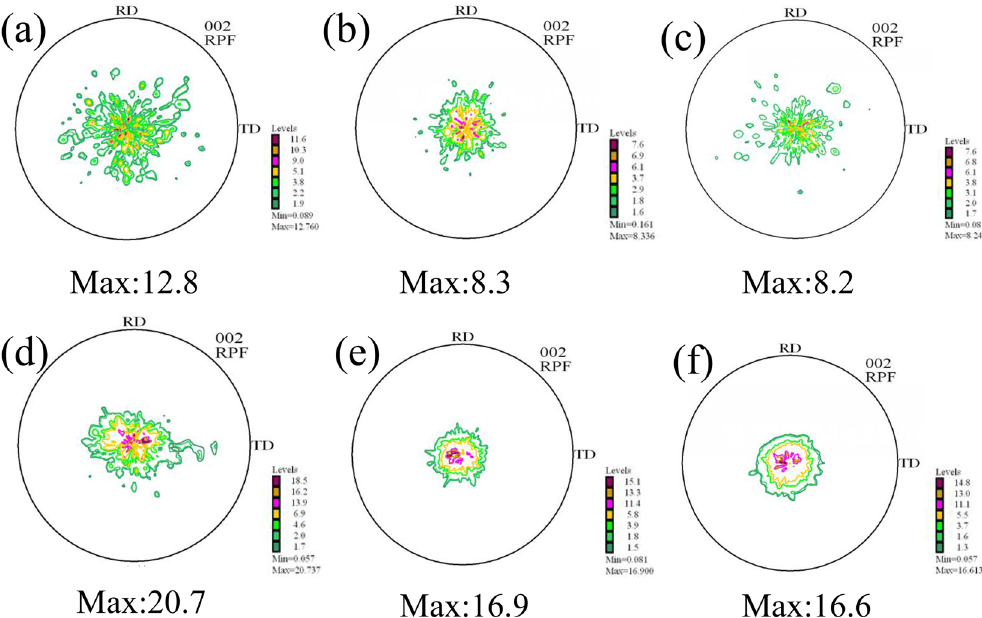
Figure 7. (0002) macrotextures of the studied alloys: ( a ) Mg-3Zn 20% rolled and aged for 25 h, ( b ) Mg-3Sn 20% rolled and aged for 35 h, ( c ) Mg-5Sn 20% rolled and aged for 35 h, ( d )Mg-3Zn 50% rolled and aged for 25 h, ( e ) Mg-3Sn 50% rolled and aged for 35 h, and ( f ) Mg-5Sn 20% rolled and aged for 35 h.